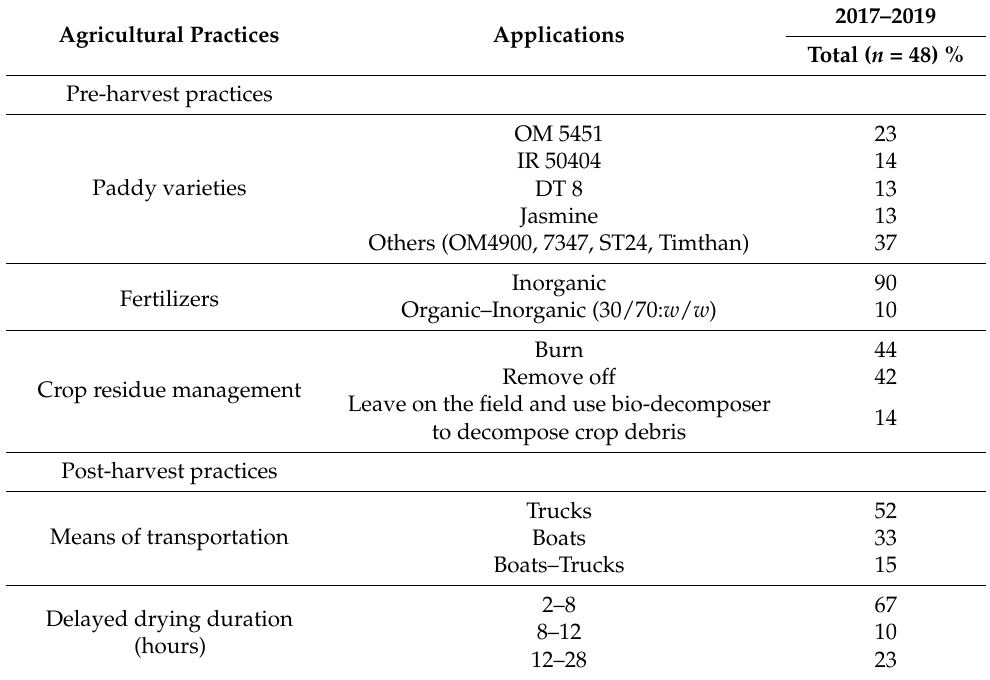
Table 2. Main pre-and post-harvest practices in paddy production in Mekong Delta,